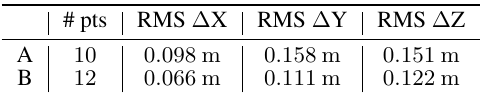
Table 3. Final accuracies at check points